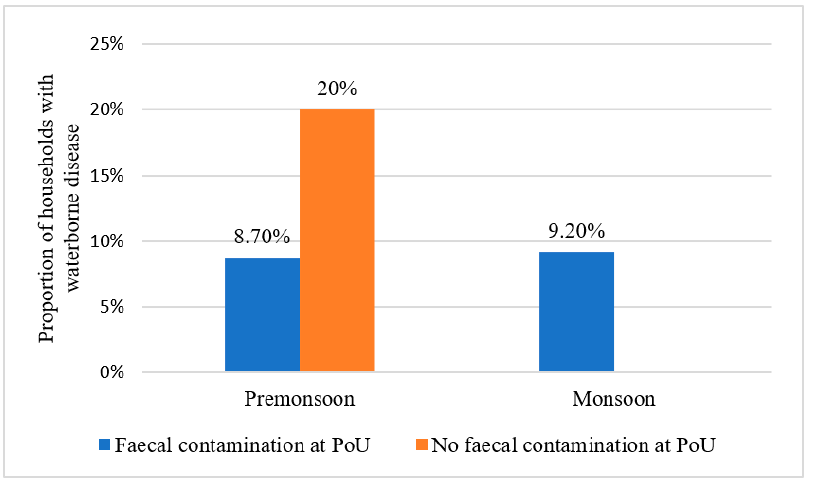
Figure 6. Proportion of households with waterborne diseases and fecal contamination of water at PoU during pre-monsoon and monsoon seasons.